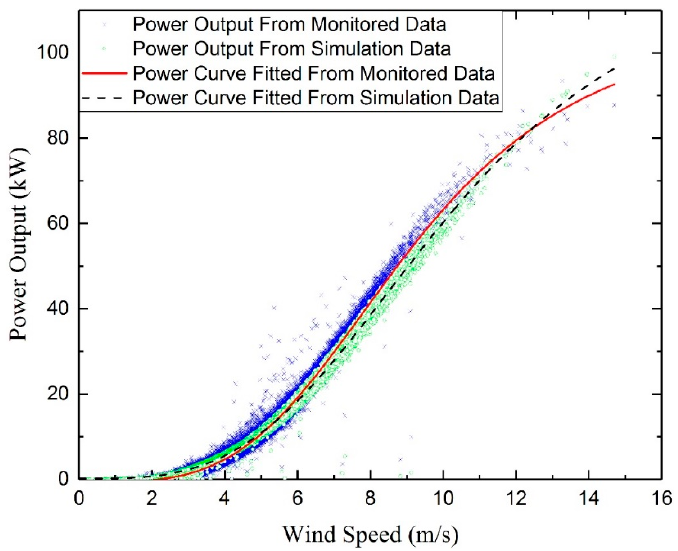
Figure 5. Comparison of the blade element momentum (BEM) model’s predicted power output and the monitoring power output of the 100 kW wind turbine.